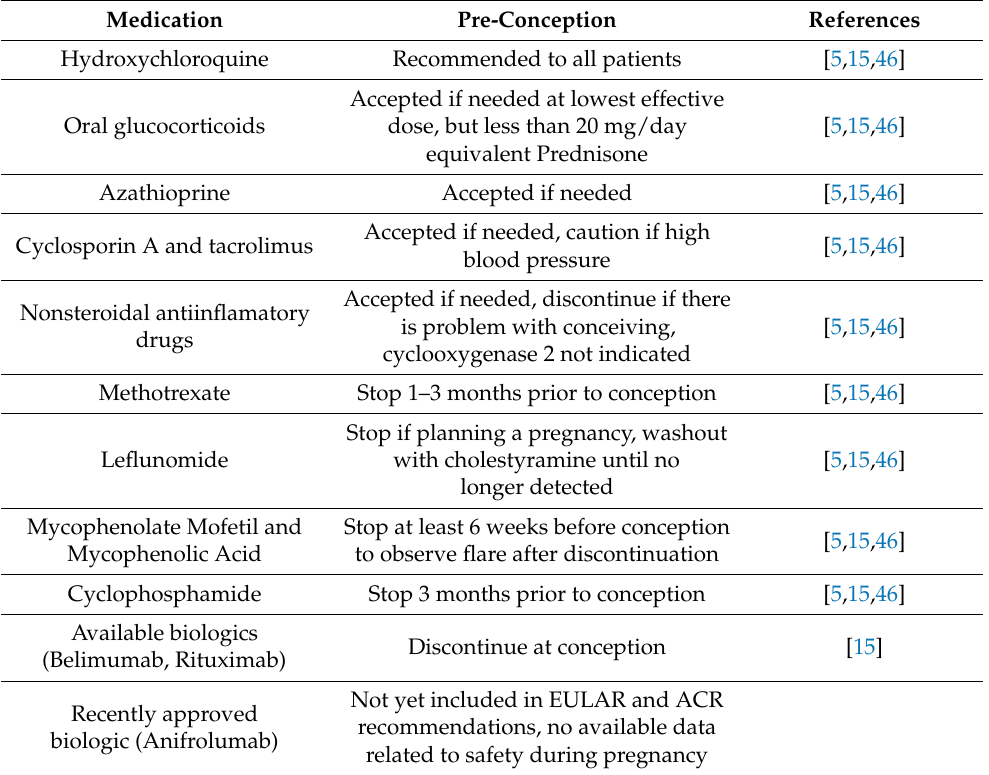
Table 3. How to use specific available medication during preconception